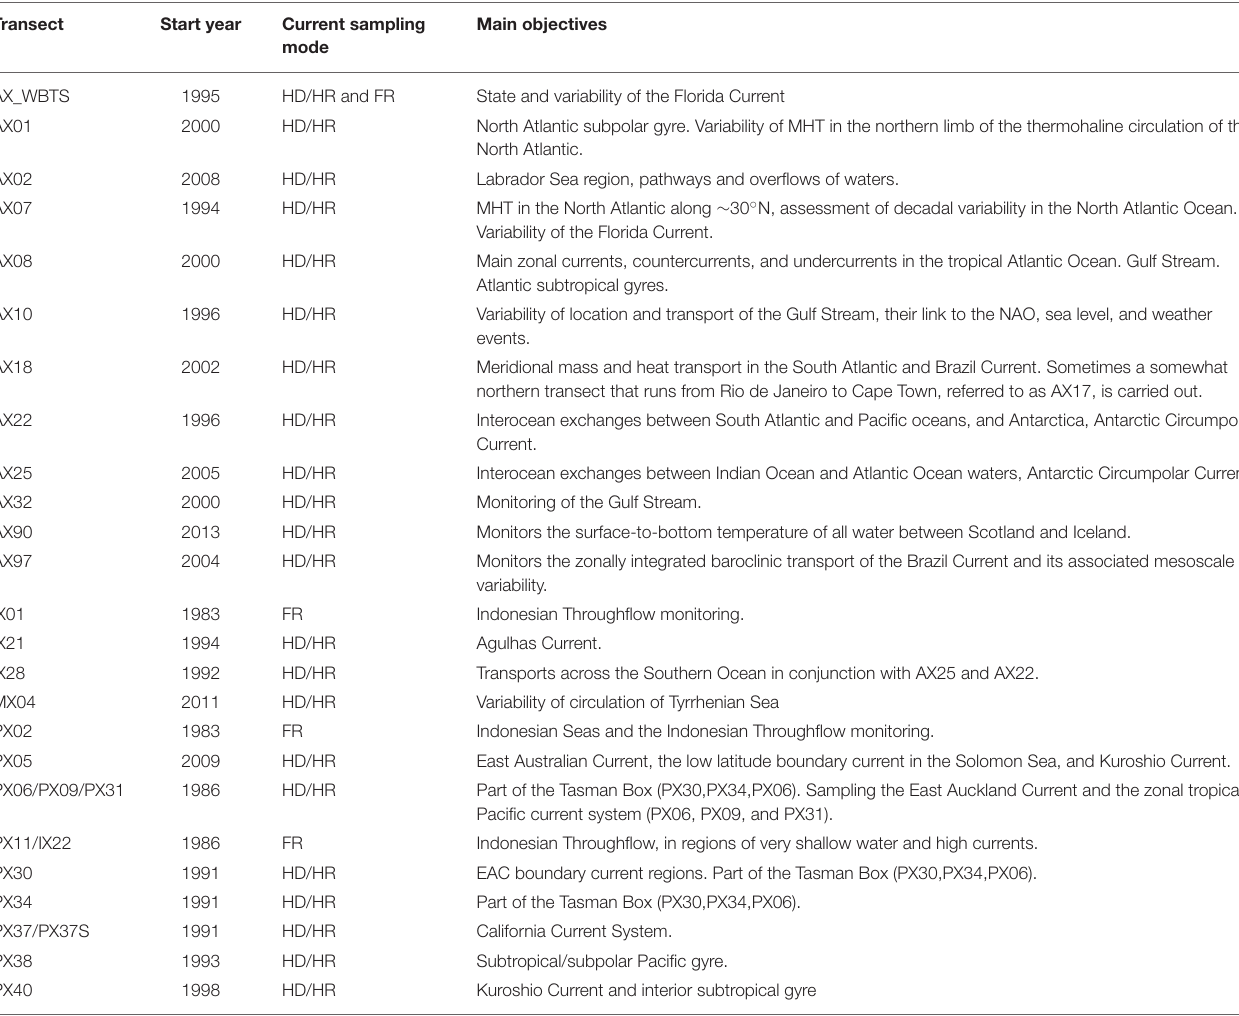
TABLE 1 | List of all currently operational XBT transects, with year of implementation, mode of operation, and main ocean properties they observe.